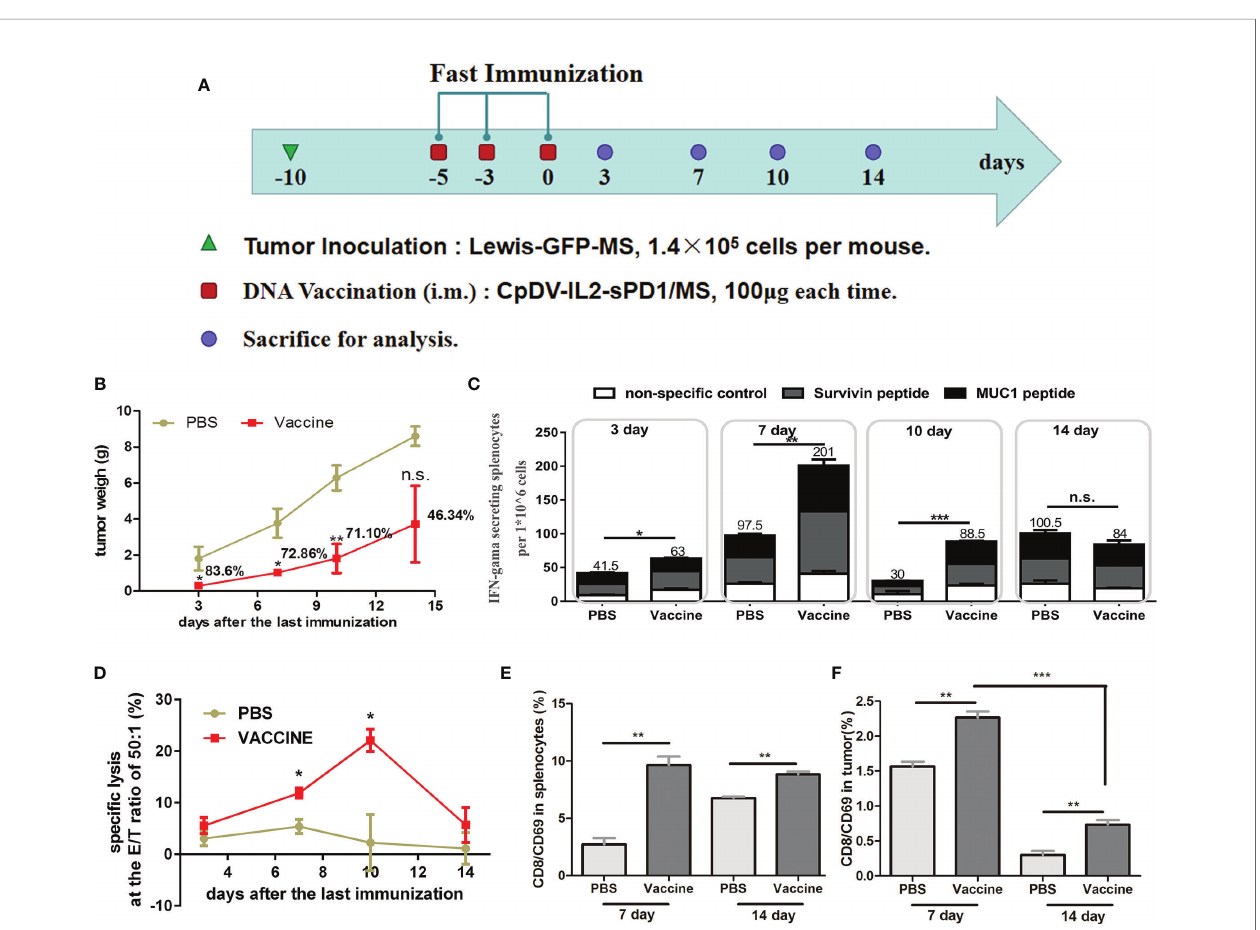
( Figure 5D ) assays indicated that fast vaccination induced an effective immune response on the third day after the last vaccination, which persisted to the 10th day.